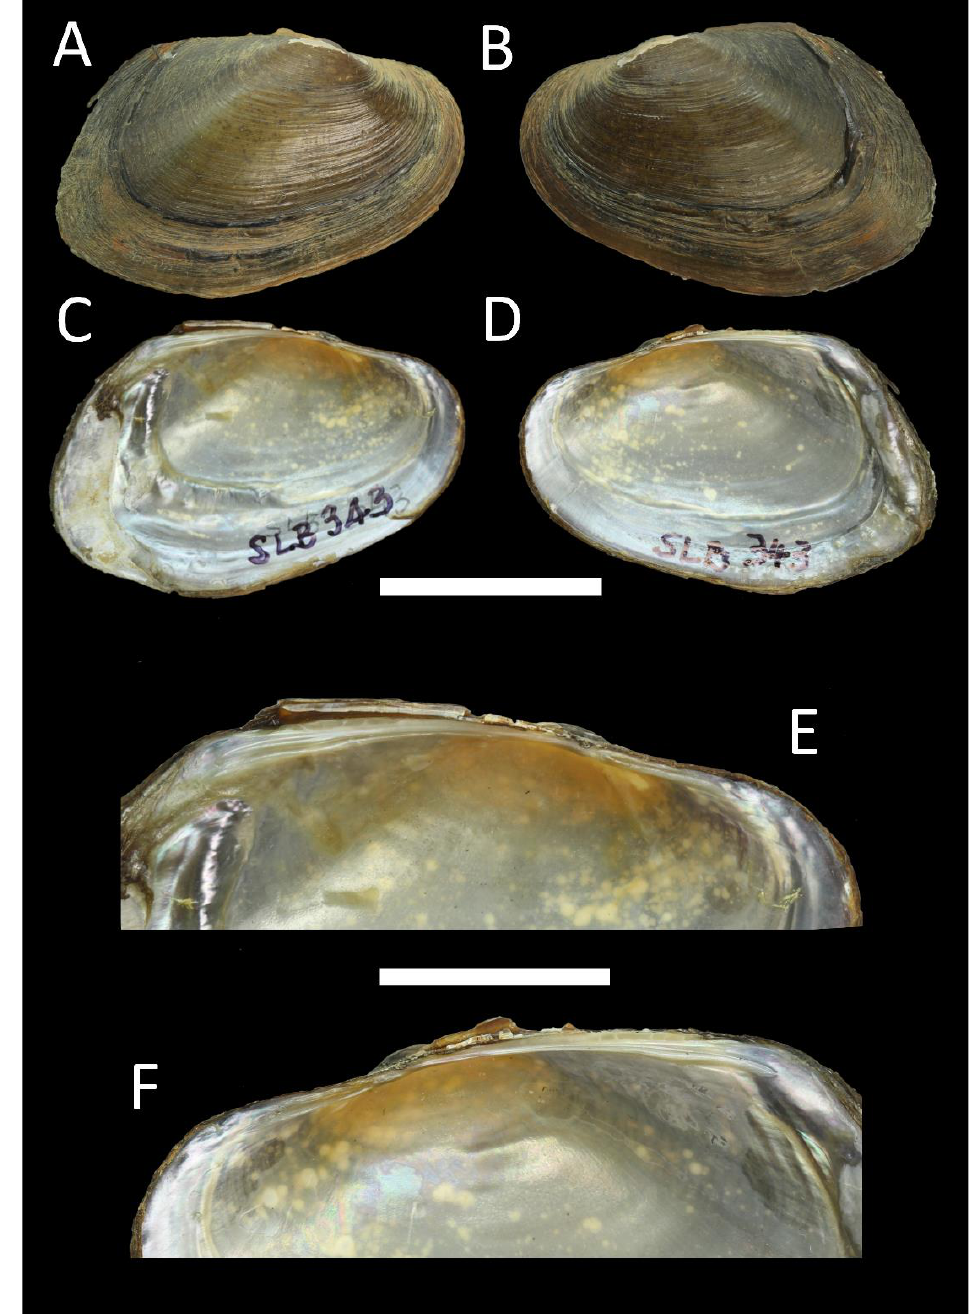
Figure 5. Shell of Trapezoideus thachiadensis sp. nov. (Contradentini) from Southern Thailand, holotype RMBH biv 1340, Klong Tha Chiad, Phatthalung Province: right ( A ) and left ( B ) valve views, inside view of left ( C ) and right ( D ) valves, interior view zoom fragment of left € and right ( F ) valves. Scale bar = 20 mm ( A – D ); scale bar = 10 mm ( E , F ). Photos: Ekaterina S. Konopleva.